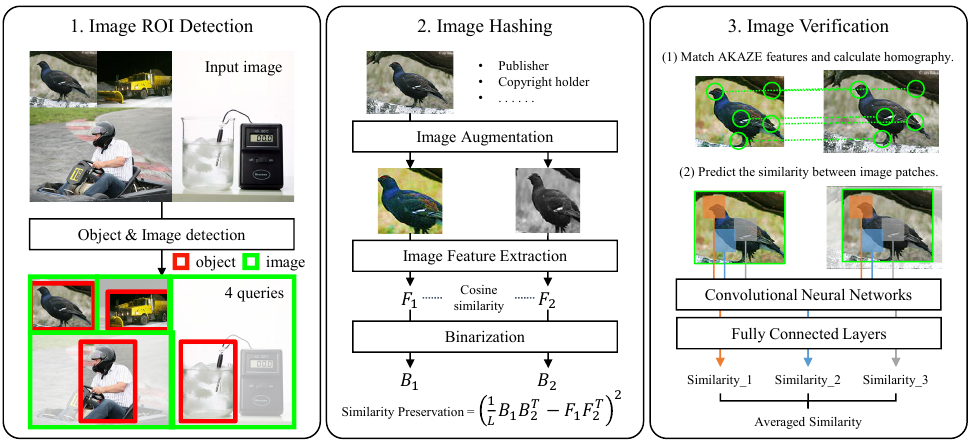
Figure 5. Overall framework for copyright photo identification. The source of these photos is Ima- geNet